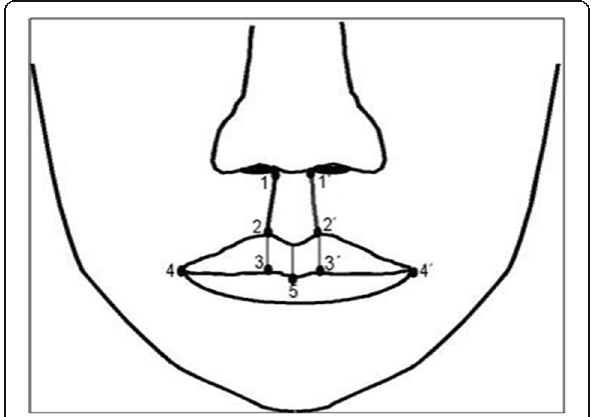
Fig. 2 Reference points of the measured structures